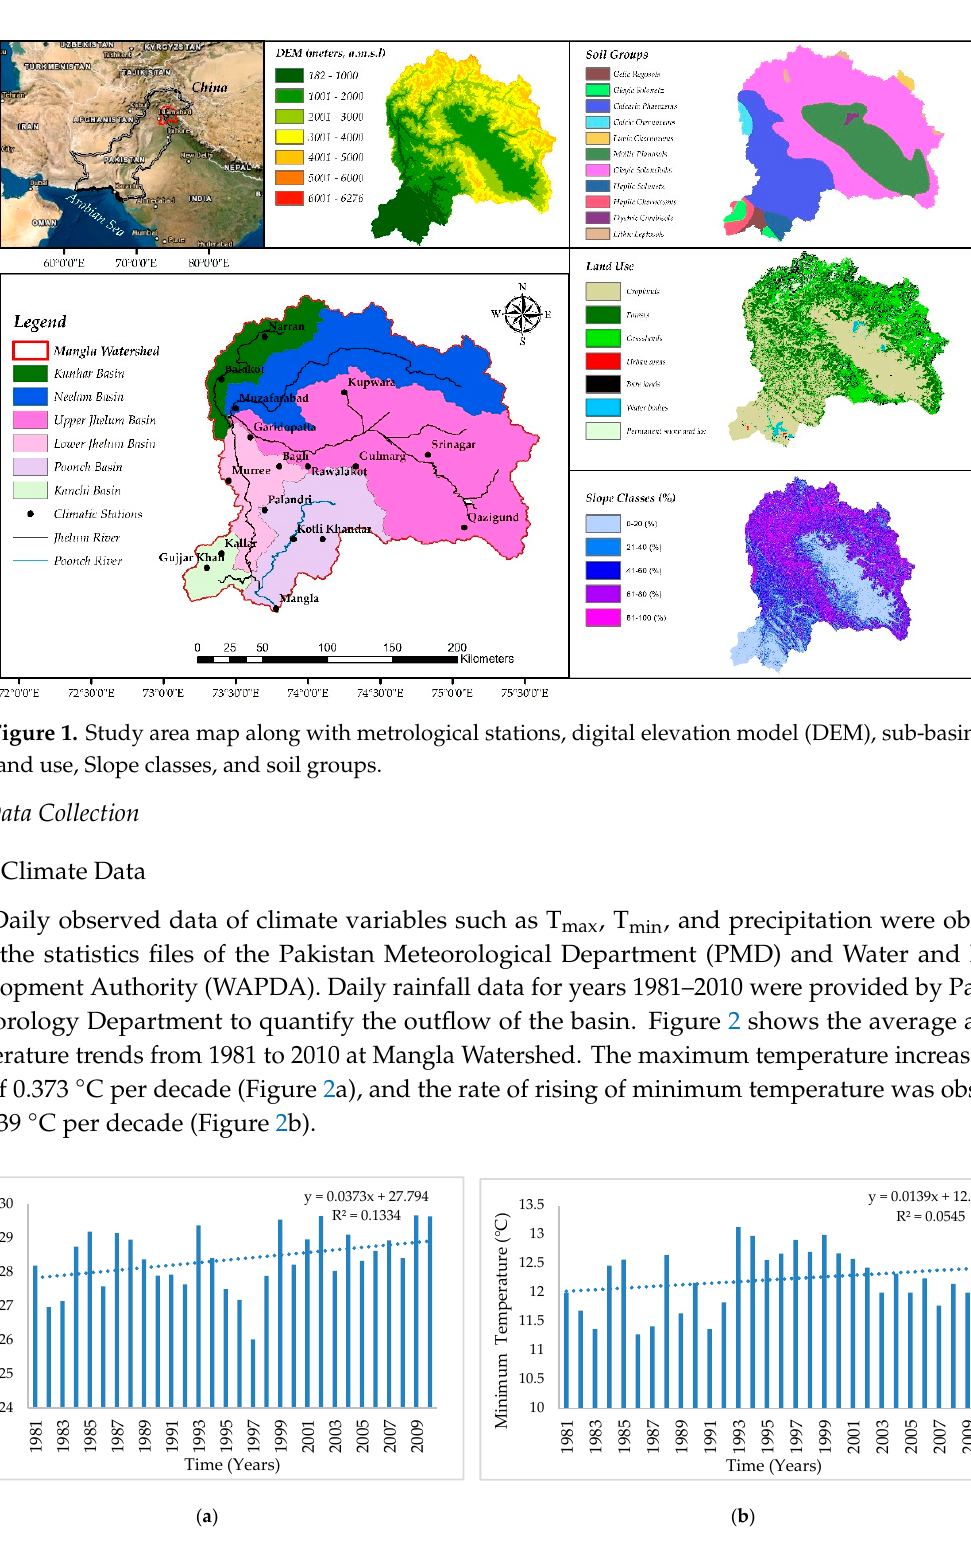
Figure 2. Historical trends of temperature in the Mangla watershed for 1981–2010 ( a ) Maximum Temperature ( b ) Minimum Temperature.